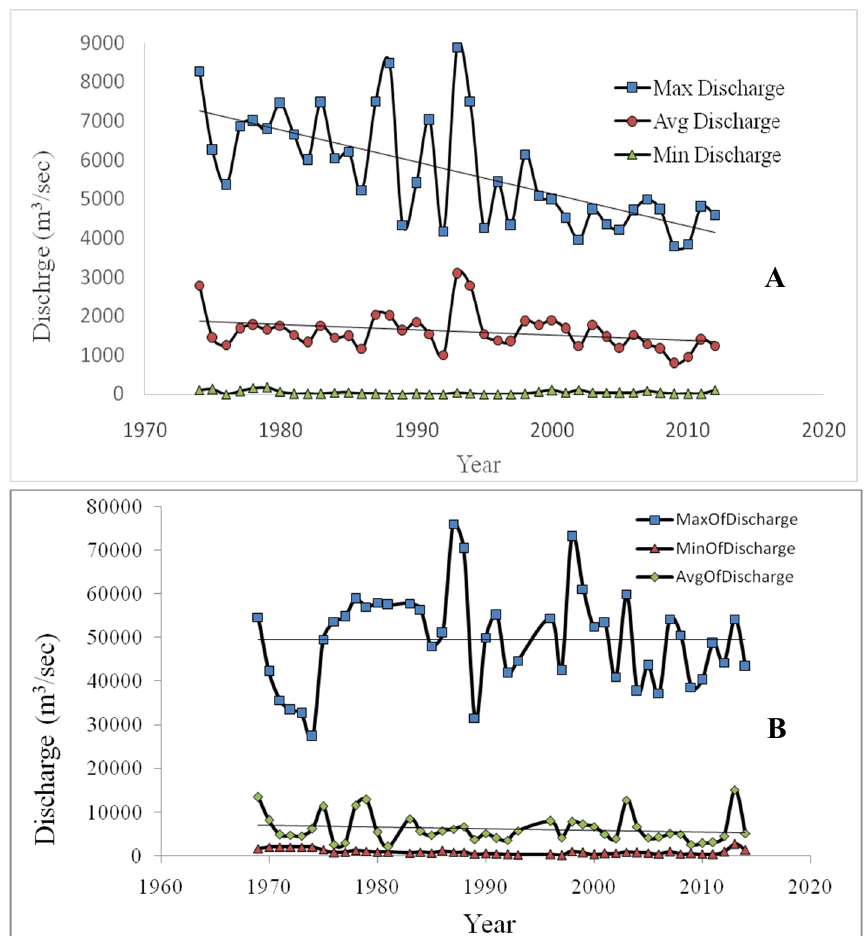
Figure 2. Yearly freshwater discharge patterns at Gorai Railway Bridge on Gorai River ( A ) and at Hardinge Bridge on Ganges River ( B ); the two peak max. discharges at both the stations are due to major floods in 1987 and 1998. Max. discharge means peak discharge of a monsoon month; average and minimum discharges are mean of 12-month values. Source: